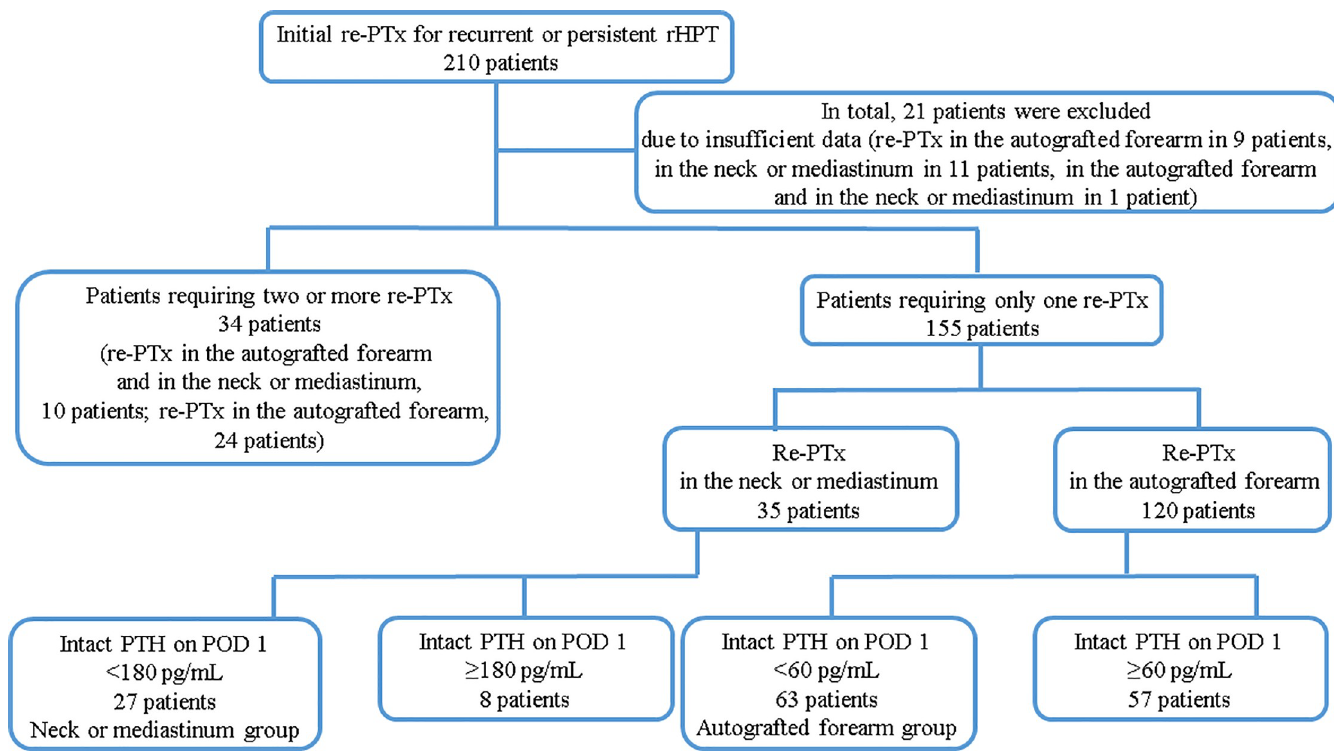
Fig 1. Patient flow chart. PTx, parathyroidectomy; POD 1, postoperative day 1; PTH, parathyroid hormone; rHPT, renal hyperparathyroidism.